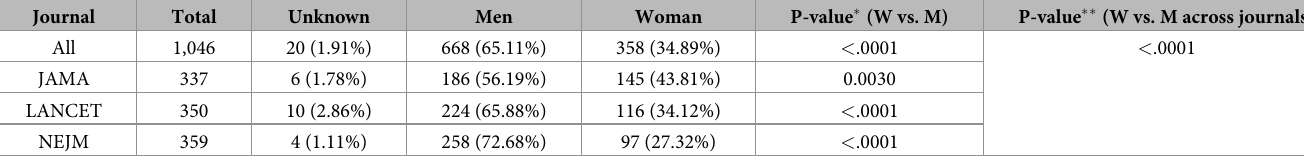
Table 5. Second authors’ publications across top medical research journals by gender.